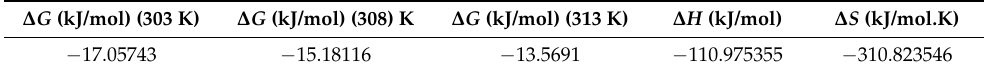
Table 2. Thermodynamic parameters for the adsorption of LVX onto the rGO-WO 3 heterostructure.